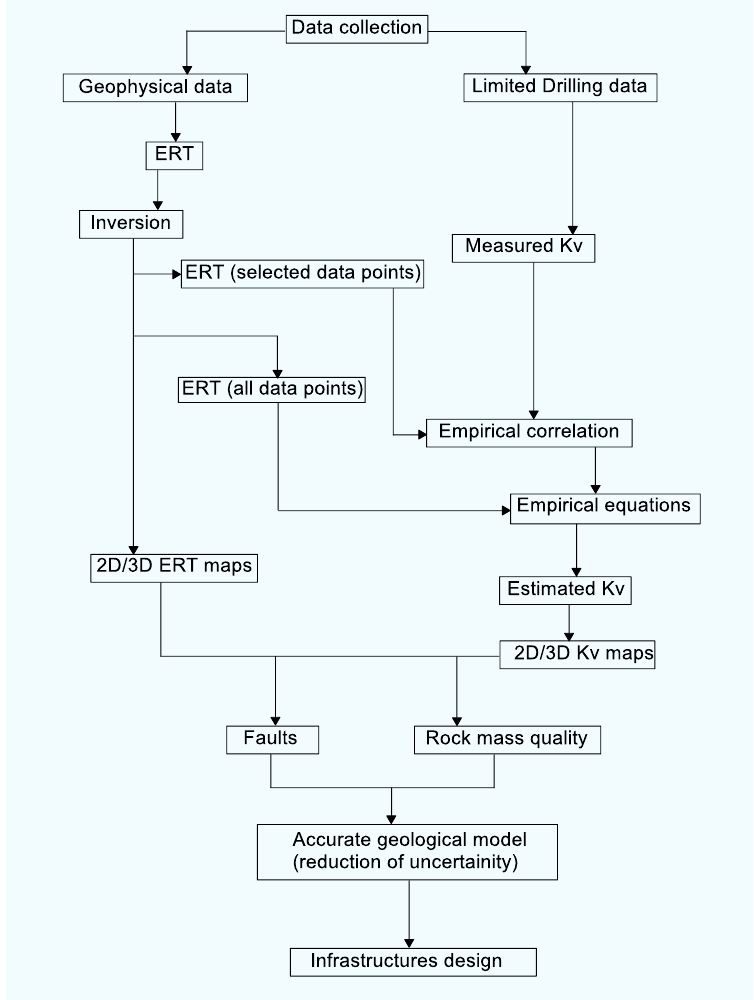
Figure 1. A flowchart to summarize the efforts to obtain an accurate geological model using geophysical approach for infrastructures